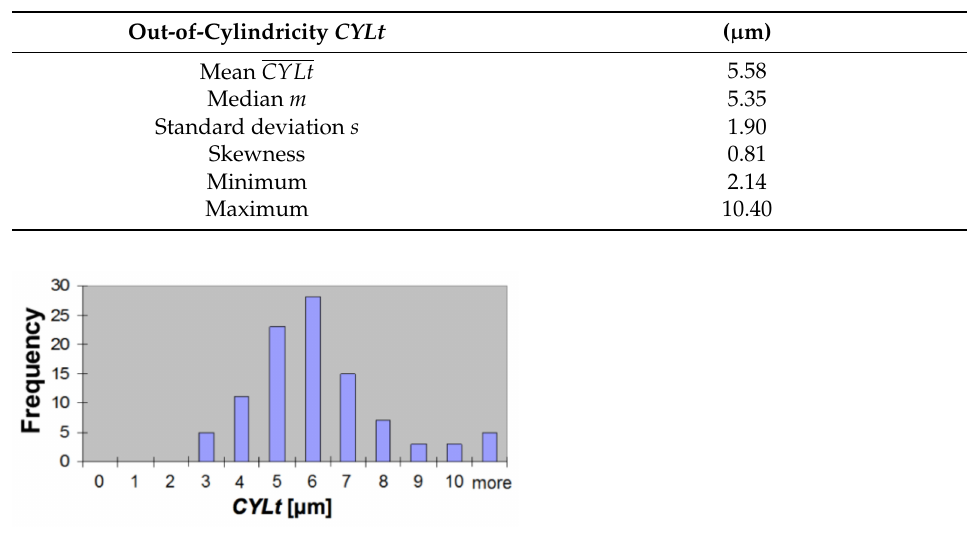
Table 2. Statistical data of the cylindricity deviation value measured with the Talyrond 365.